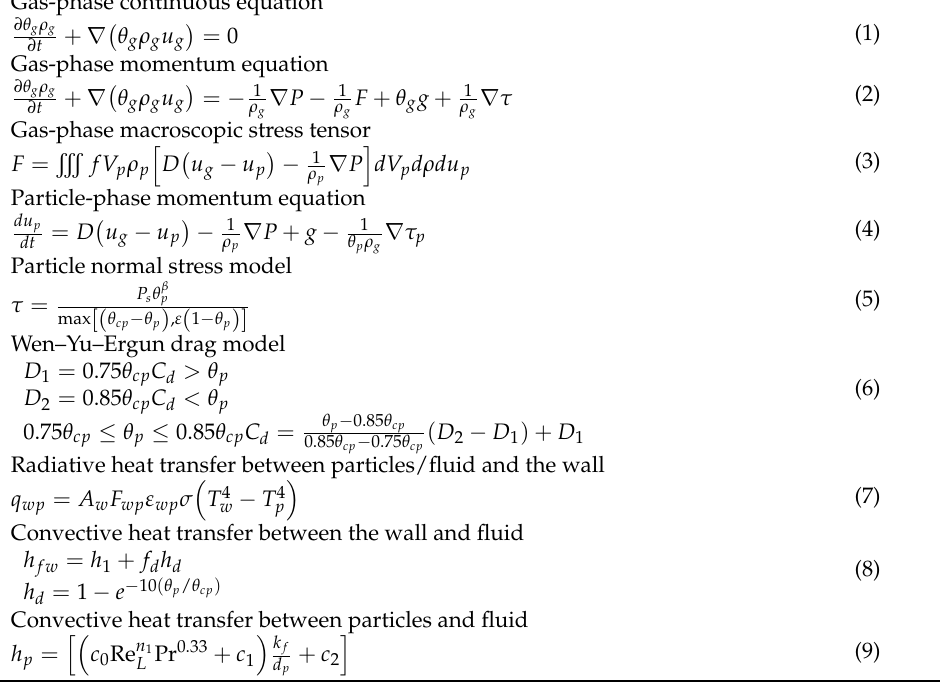
Table 3. Governing equations and heat-transfer model in the numerical simulations. Gas-phase continuous equation ∂θ g ρ g